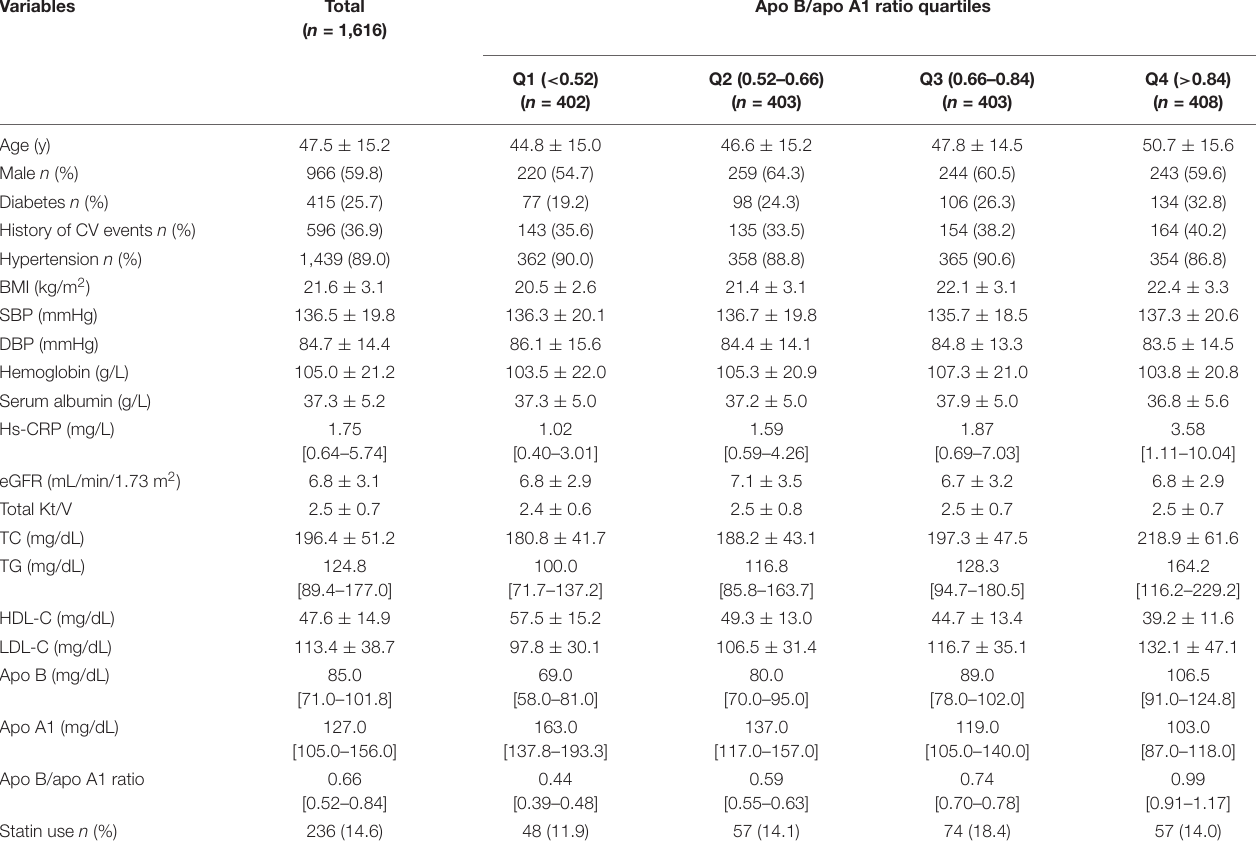
TABLE 1 | Baseline characteristics of the study patients according to apo B/apo A1 ratio quartiles.